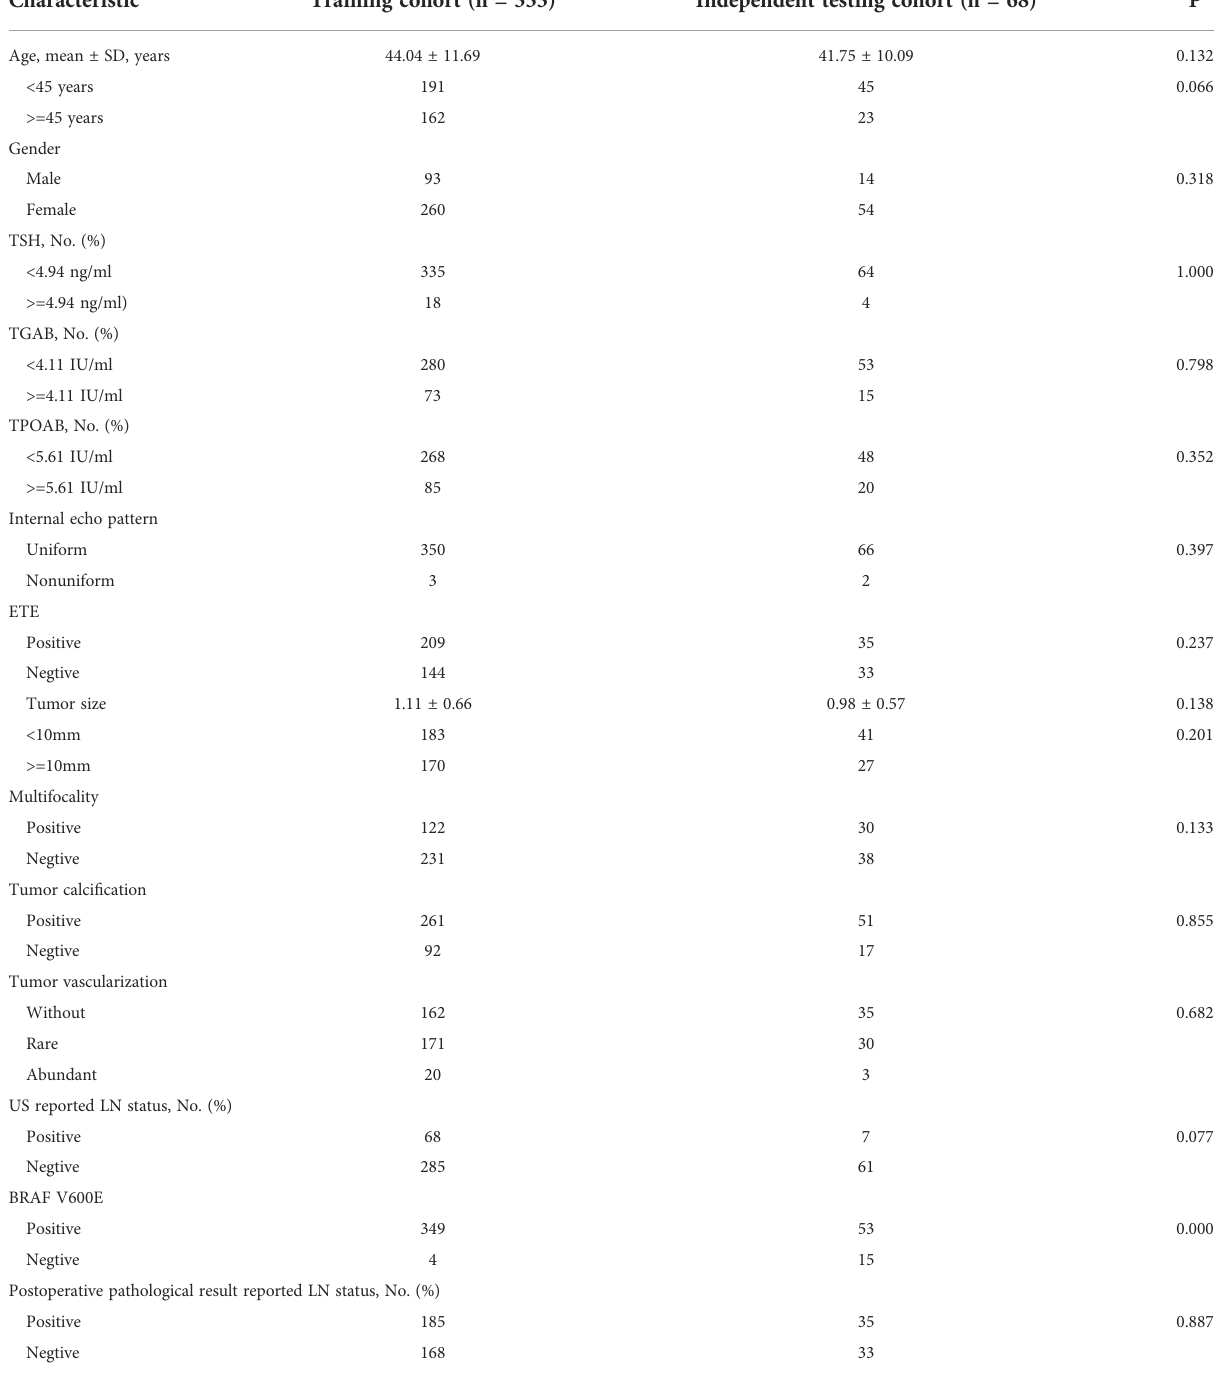
TABLE 1 Patient characteristics of the training cohort and the independent testing